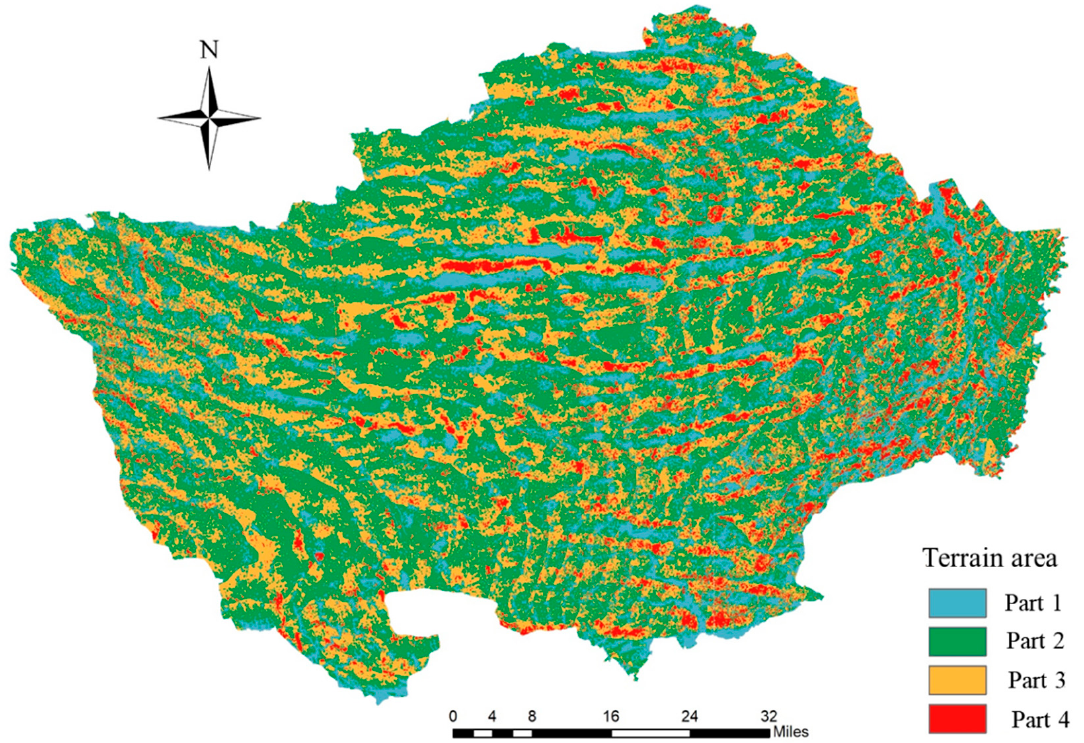
Figure 4. Topographic distribution map of the study area.